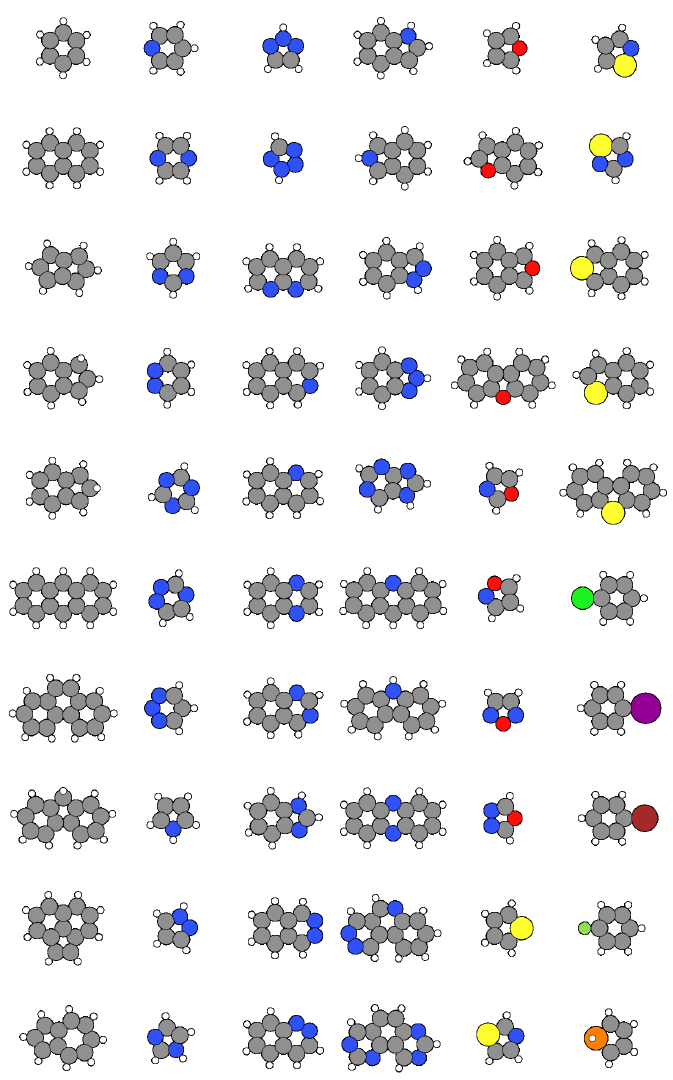
Figure 1. Ball and stick representation of all the molecules included in the SPMTH-60 dataset. Carbon (grey), hydrogen (white), nitrogen (blue), oxygen (red), sulphur (yellow), chlorine (lime), iodine (purple), bromine (maroon), fluorine (green), and phosphorus (orange) atoms are represented by color